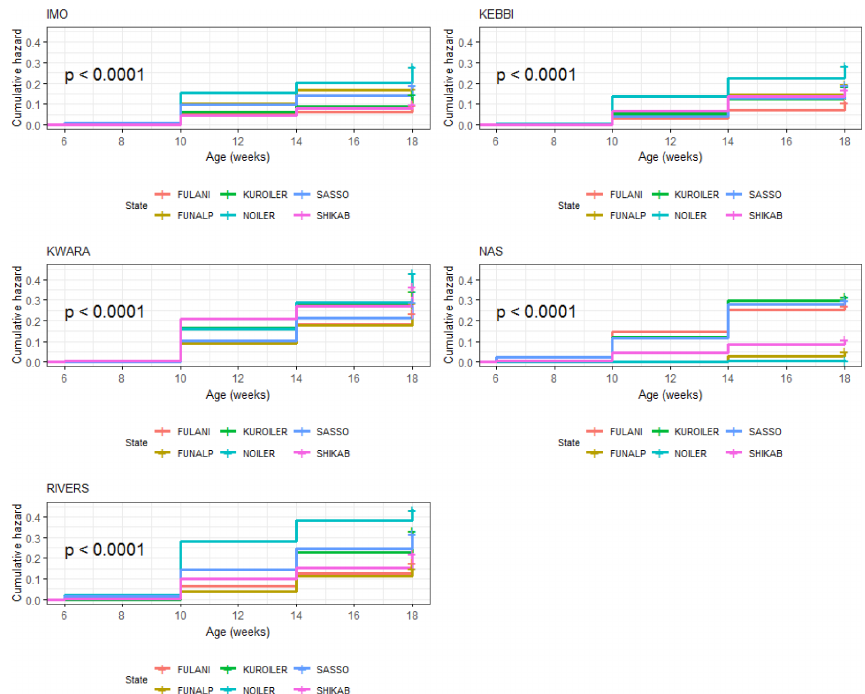
Figure 15. Breed by environment interaction on overall cumulative hazard of birds (agroecologies) during growing phase in ACGG Nigeria project zones (6–18 weeks)